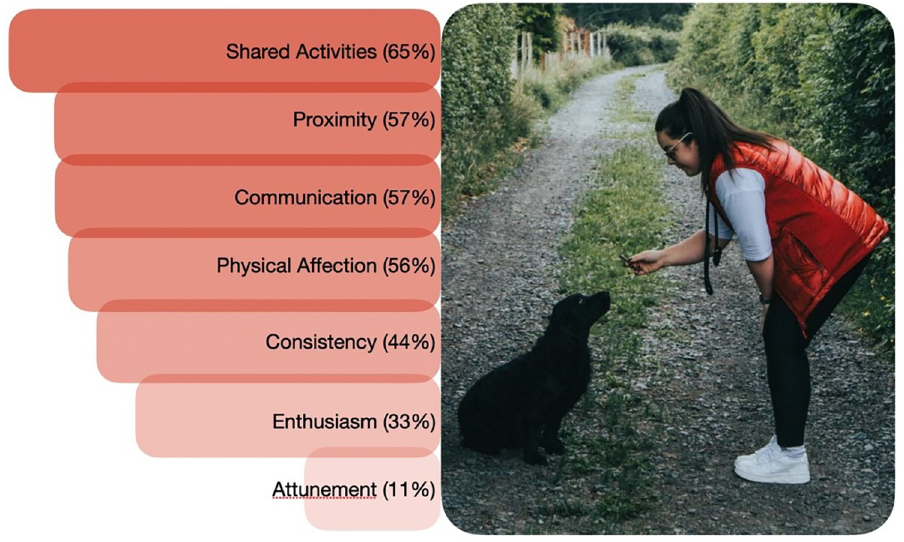
Fig 2. Visualisation of the themes identified through thematic analysis, with reference to data. Photo credit: Original photo by Kyle Mackie on Unsplash, reprinted here under a CC BY license.